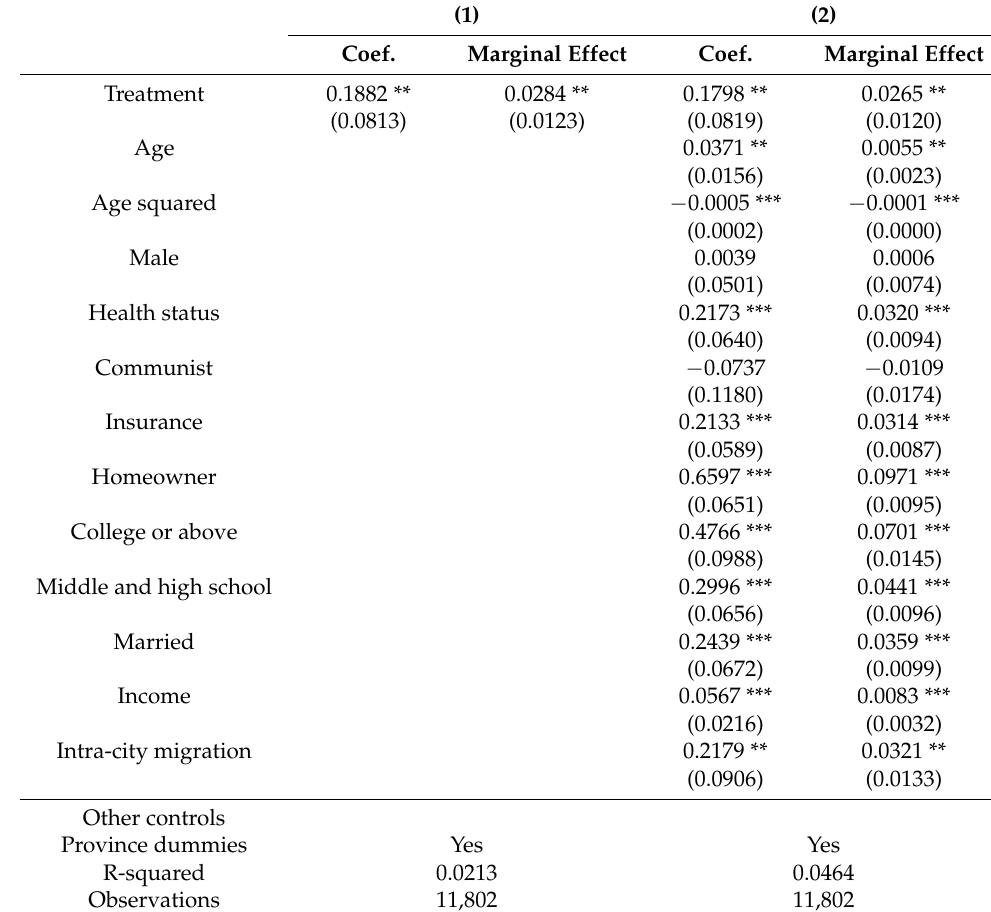
Table 2. Baseline regression results: impacts of the reform on settlement